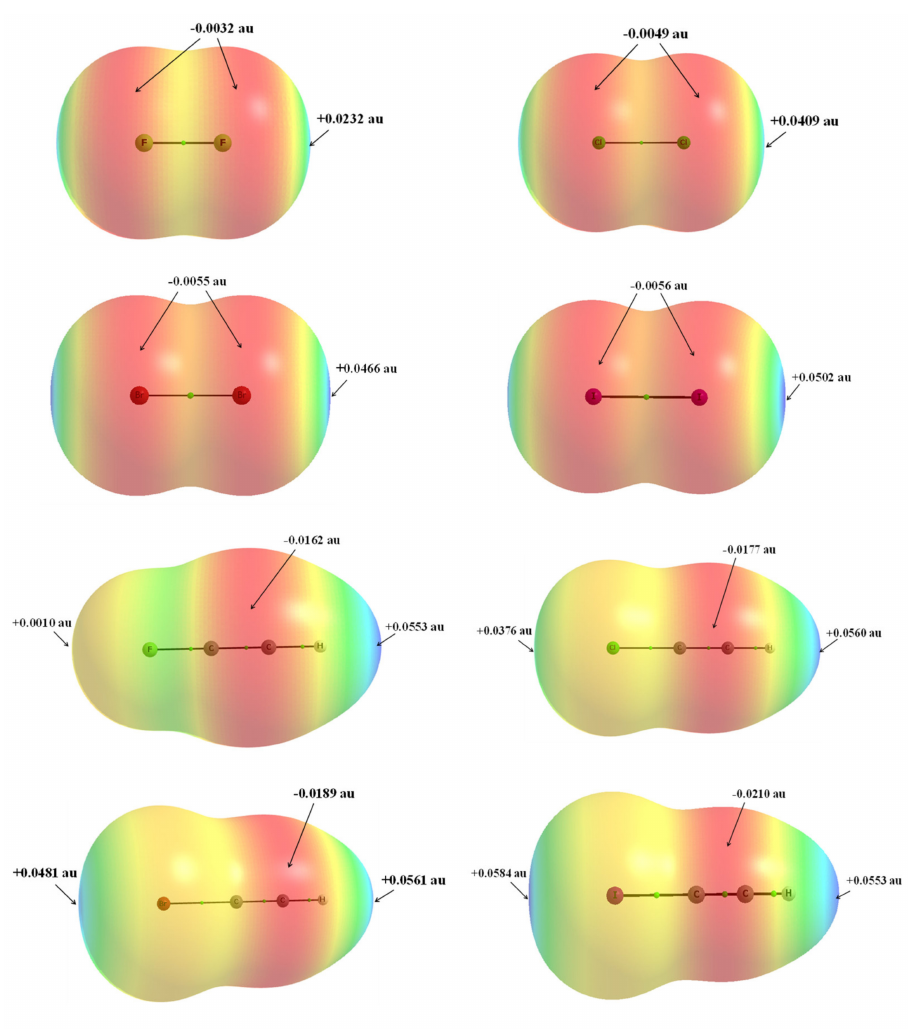
Figure 5. Molecular graphs of X 2 and HCCX molecules: small green circles correspond to the bond critical points; the EP molecular surfaces characterised by the 0.001 au electron density are presented; blue colour corresponds to the maximum positive EP; red colour corresponds to the negative minimum EP; and the scale of colours concerns each of the molecules separately. According to left-to-right and top-to-bottom order, the following molecules are presented: F 2 , Cl 2 , Br 2 , I 2 , FCCH, ClCCH, BrCCH and